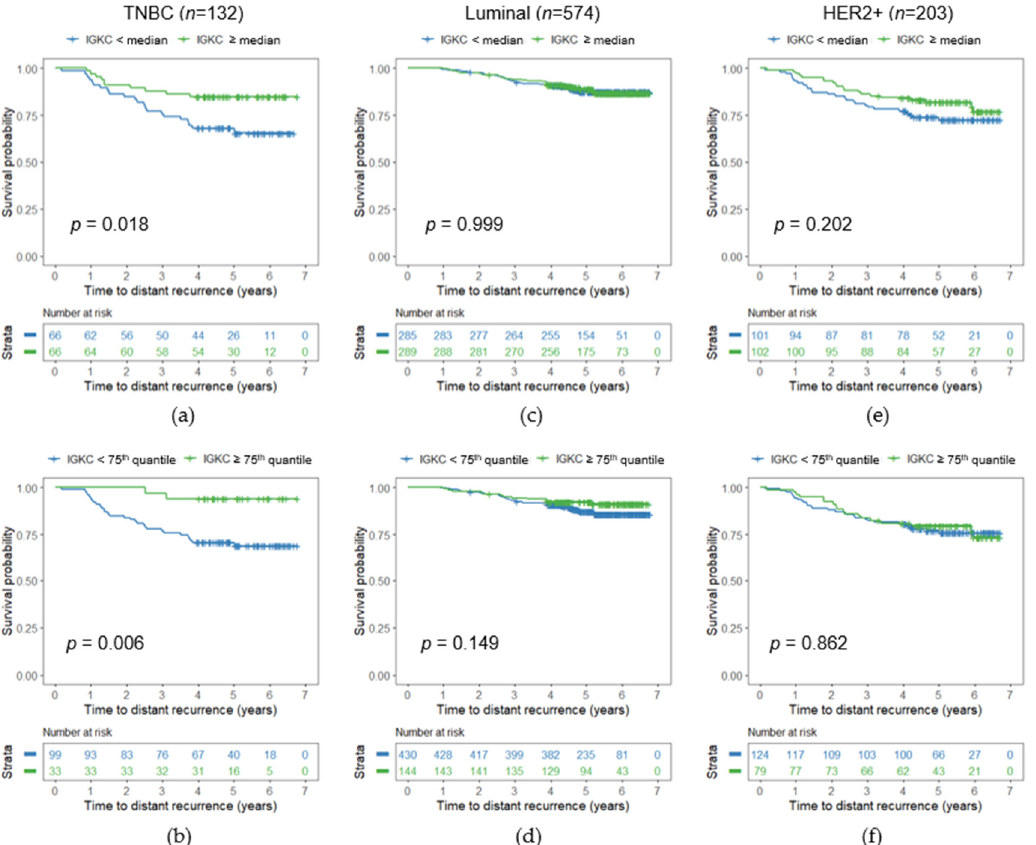
Figure 3. Influence of cancer IGKC expression on DDFS illustrated by Kaplan–Meier plots for ( a , b ) triple-negative (TNBC), ( c , d ) luminal, and ( e , f ) HER2+ cancers in the FinHer trial, with IGKC dichotomized as low (<median of the corresponding subtype) and high ( ≥ median of the corresponding subtype) (upper panels) as well as dichotomized as low (<75th quantile of the corresponding subtype) and high ( ≥ 75th quantile of the corresponding subtype) (lower panels). The p -value from the log-rank test is given in the